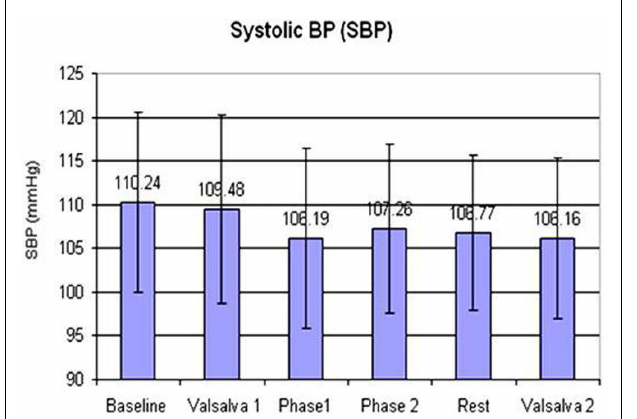
FIGURE 3 |The changes in heart rate (HR) across the tasks.